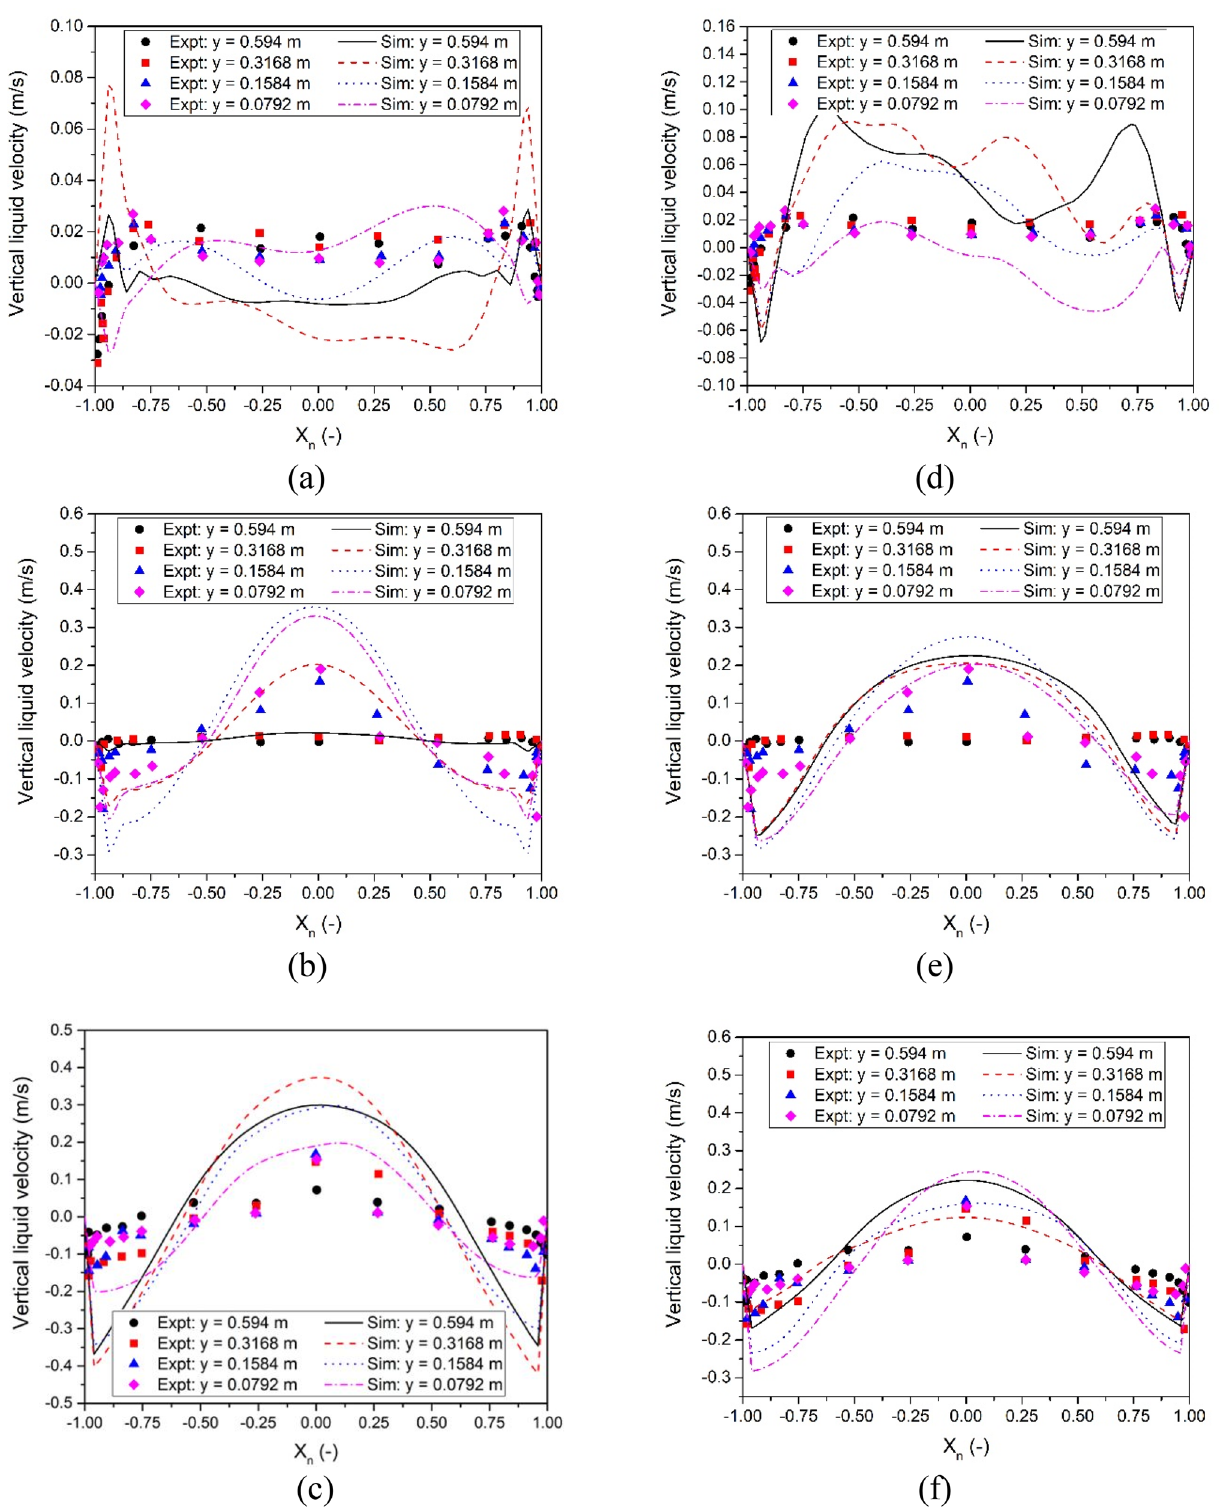
Fig. 14 Effect of bubble size on time-averaged vertical liquid velocity for a A1 (100%), 2 mm bubble; b A4 (69%), 2 mm bubble, c A7 (18%), 2 mm bubble, d A1 (100%), 8 mm bubble; e A4 (69%), 8 mm bubble, f A7 (18%), 8 mm bubble (U